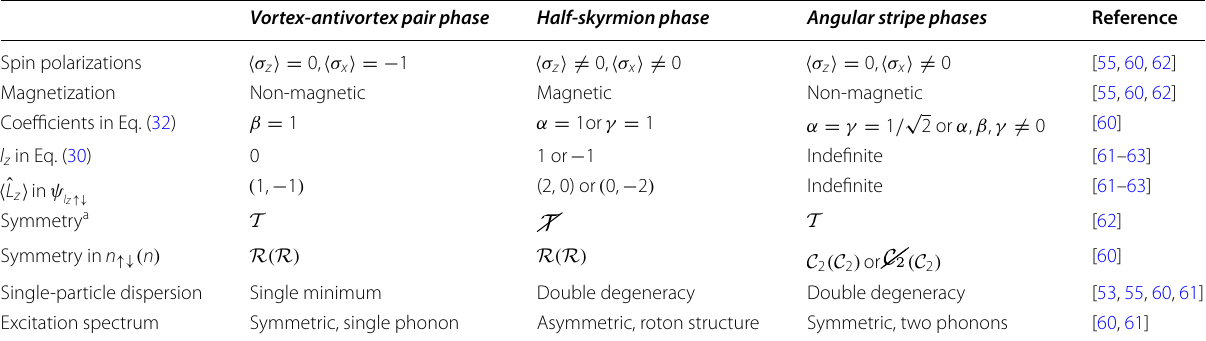
a T , R and C 2 denote the time-reversal symmetry, continuous, and twofold rotational symmetries, respectively